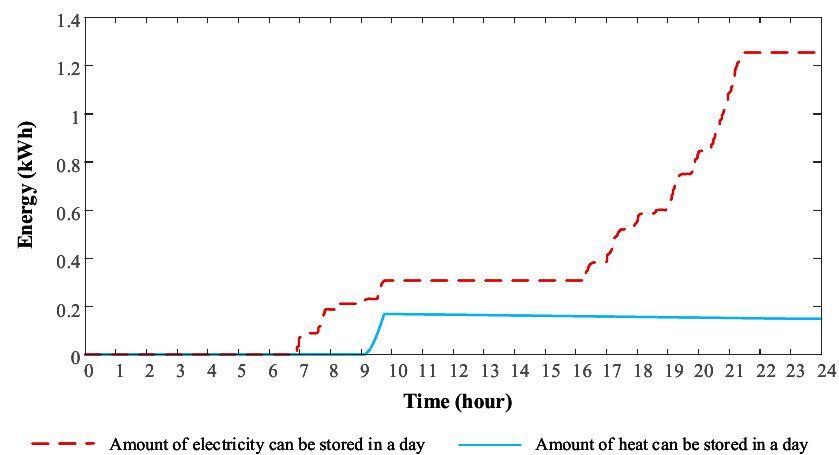
Figure 12. The accumulative redundant energy can be stored in energy storage system by applying the modified CHP control algorithm.